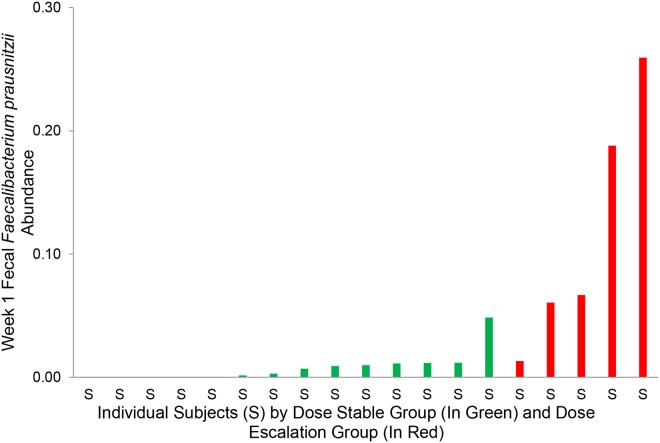
Fecal Faecalibacterium prausnitzii Abundance by Tacrolimus Dosing Groups.Each individual subject is represented on the x-axis and the week 1 fecal Faecalibacterium prausnitzii abundance is represented on the y-axis. Individual subjects in the Dose Stable Group are represented in green (the 14 subjects on the left) and individuals subjects in the Dose Escalation Group are represented in red (the 5 subjects on the right). The Dose Escalation Group had a significantly higher Faecalibacterium prausnitzii proportion than the Dose Stable Group (11.8% vs. 0.8%, respectively, uncorrected P = 0.002, Wilcoxon Rank-Sum test, P<0.05 after Benjamini-Hochberg correction for multiple hypotheses).